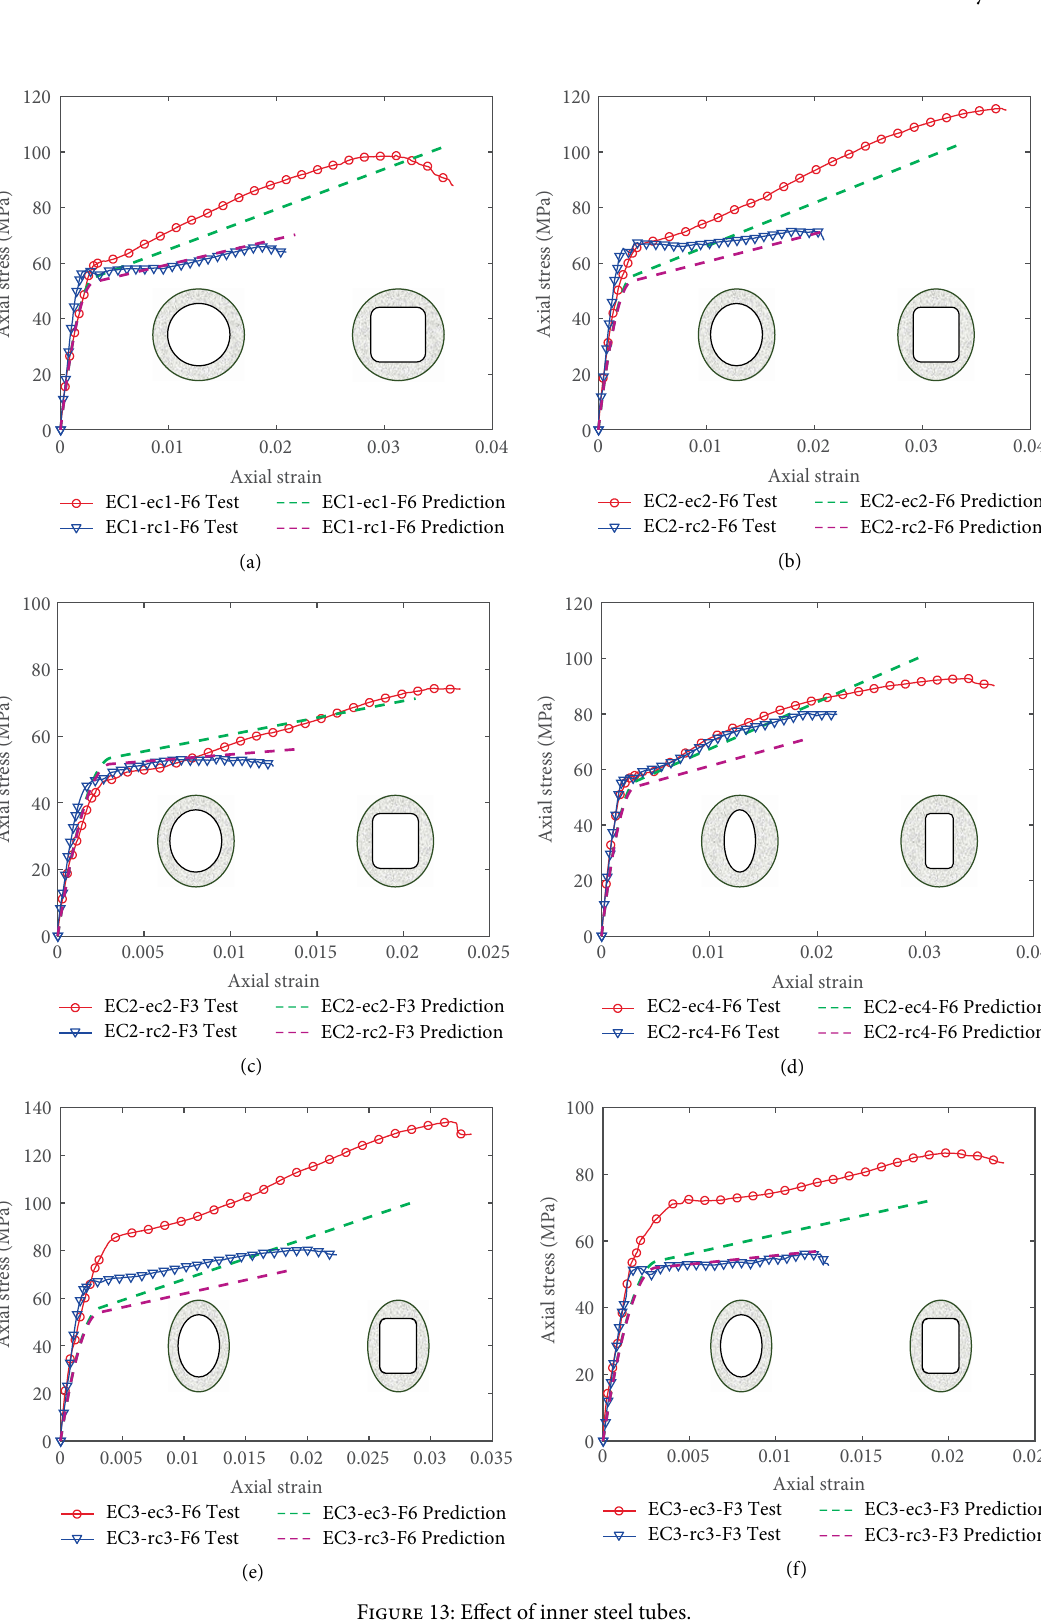
Figure 13: Effect of inner steel